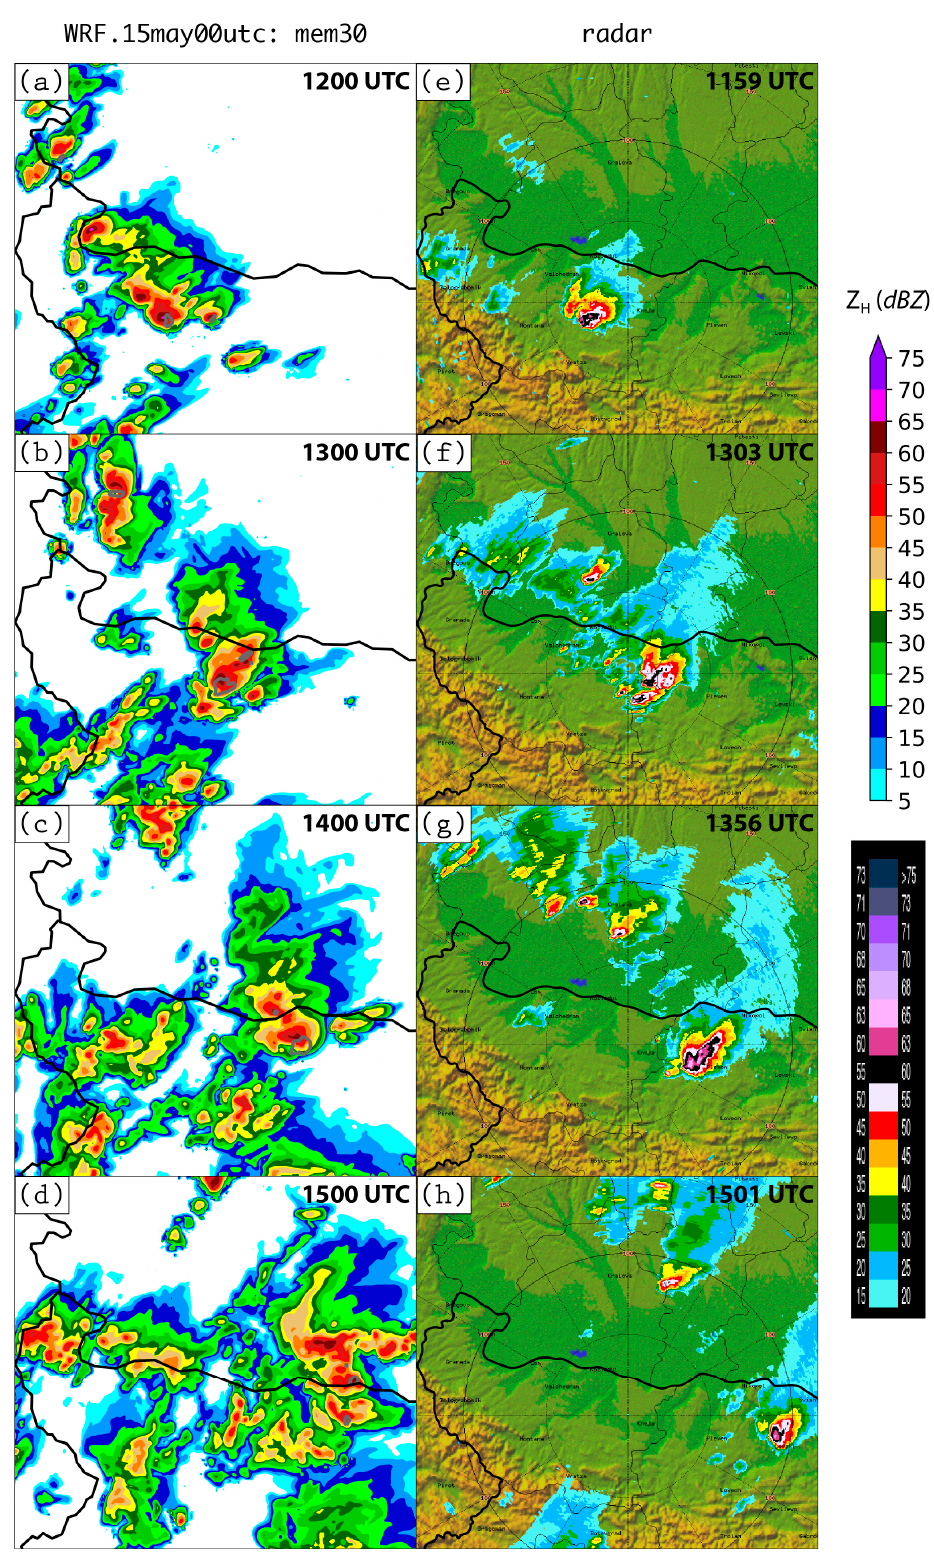
Figure 17. Simulated reflectivity in member 30 from WRF.15may00utc at ( a ) 12:00 UTC, ( b ) 13:00 UTC, ( c ) 14:00 UTC and ( d ) 15:00 UTC compared against reflectivity data from the Bardarski Geran radar at ( e ) 11:59 UTC, ( f ) 13:03 UTC, ( g ) 13:56 UTC and ( h ) 15:01 UTC. The UH = 180 m 2 s − 2 value in the WRF simulations is contoured in